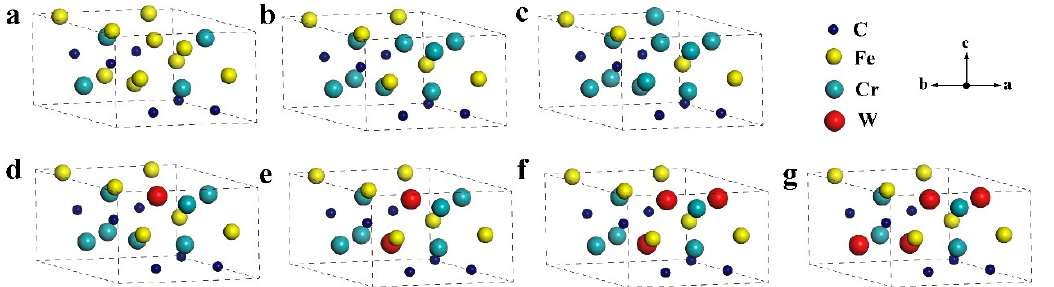
Figure 1. Unit cells of M 7 C 3 carbides with crystal structures: ( a ) Fe 5 Cr 2 C 3 ; ( b ) Fe 3 Cr 4 C 3 ; ( c ) Fe 2 Cr 5 C 3 ; ( d )Fe 3 Cr 3.5 W 0.5 C 3 ; ( e ) Fe 3 Cr 3 W 1 C 3 ; ( f ) Fe 3 Cr 2.5 W 1.5 C 3 ; ( g ) Fe 3 Cr 2 W 2 C 3 .